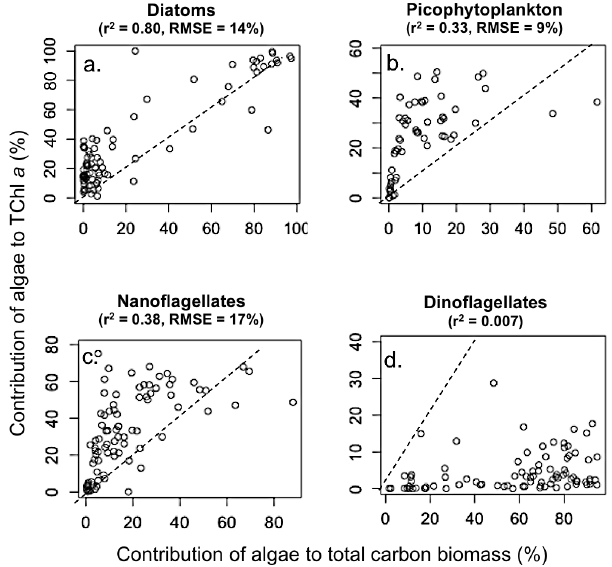
Figure 9. Scatter diagrams of the contribution of (a) diatoms, (b) pi- cophytoplankton, (c) nanoflagellates and (d) dinoflagellates to to- tal chlorophyll a (Chl a ) concentration (calculated by CHEMTAX) as a function of their contribution to total carbon biomass (calcu- lated from biovolume, see Materials and methods). The dashed line represents a 1 : 1 relationship. The Pearson correlation coefficient ( r 2 ) is indicated for each algal group. The root-mean-square error (RMSE) depicts the predictive capabilities of carbon biomass from the CHEMTAX derived algal groups. In total, 95% of the algal car- bon biomass estimated from the CHEMTAX derived algal groups is in the range ± 2 × RMSE from the least-squares regression